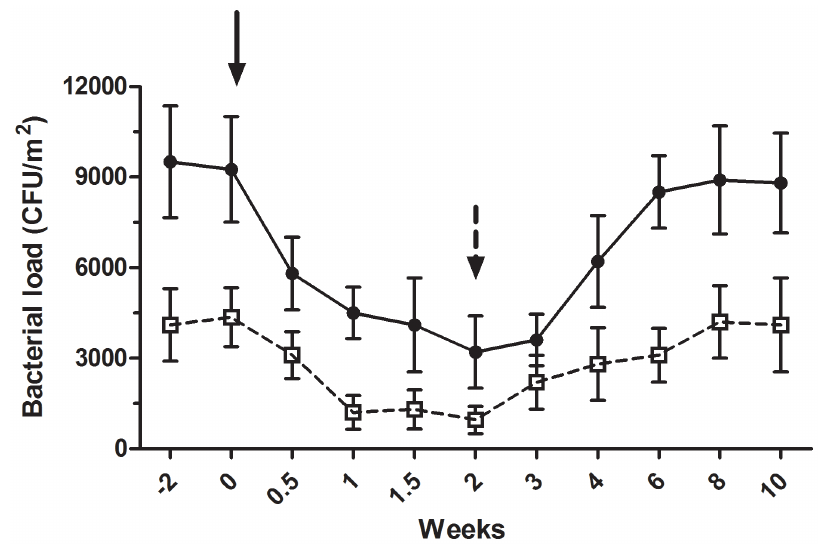
Figure 5. Time course of coliforms and S.aureus surface counts. A time-trial of coliforms (black circles) and S. aureus (white circles) counts was performed at the geriatrics department of the AZ Lokeren hospital. Surface counts, indicated as CFU/m 2 , were measured after application of conventional (from week 2 2 to 0) and microbial (from week 0 to 2) cleaning, followed by a subsequent period of conventional cleaning (from week 2 to 10). The application of the probiotic-based products led to a significant decrease in the pathogenic load of coliforms (p , 0.0001) and S. aureus (p=0.003). Black arrow: beginning of the microbial cleaning. Black dotted arrow: conventional cleaning.